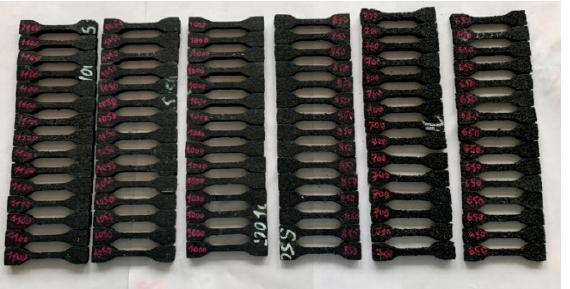
Figure 9. Samples of the elastomeric material with various densities prepared for ageing tests (high temperature and UV radiation).